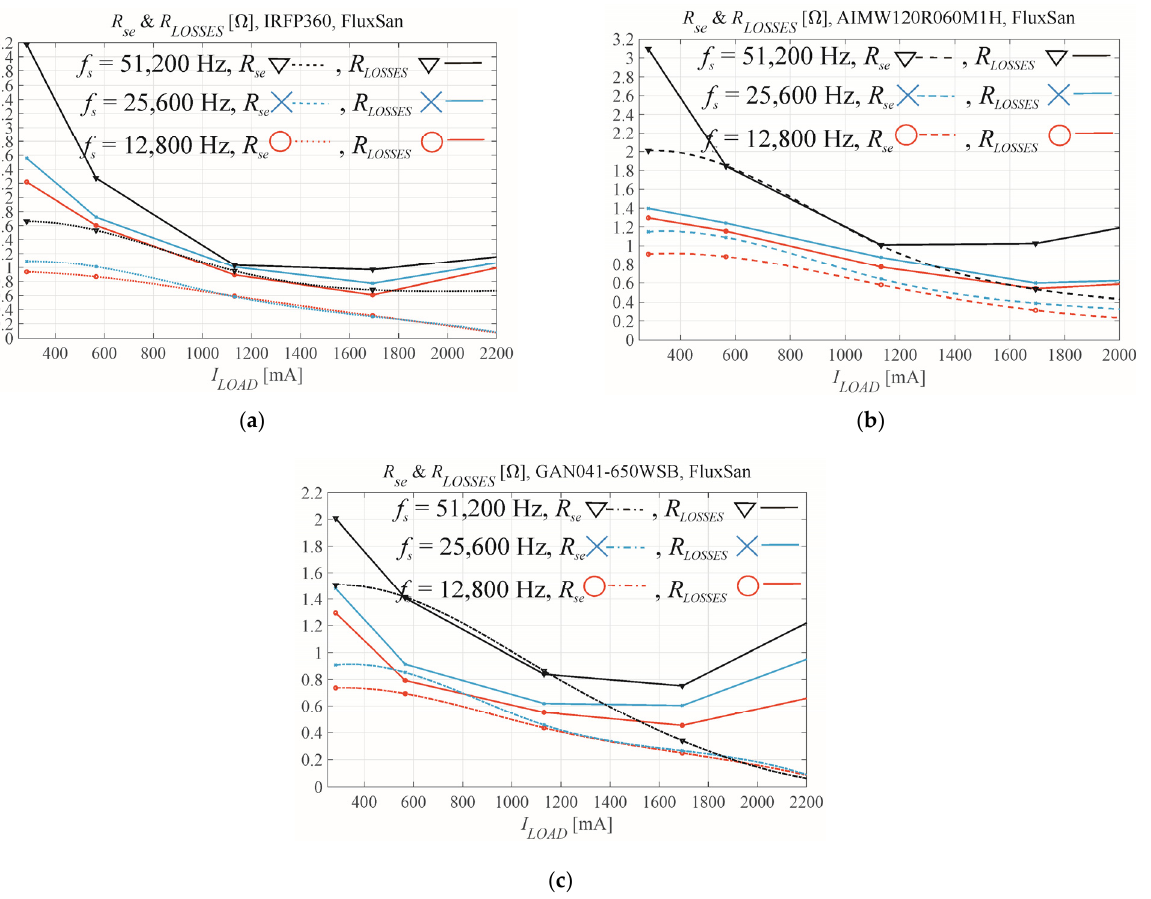
Figure 12. The serial resistances R se and R LOSSES for ( a ) Si, ( b ) SiC, and ( c ) GaN transistors when using the coil core material